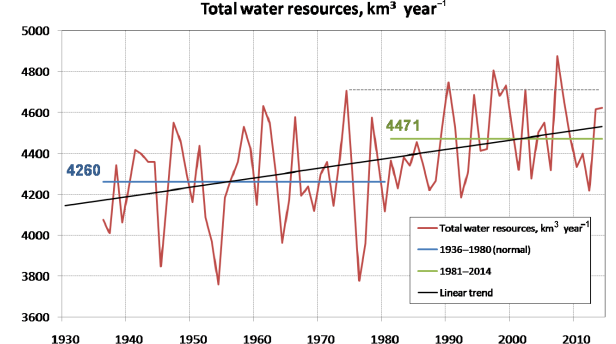
Figure 1. The long-term dynamics of renewable water resources of the Russian